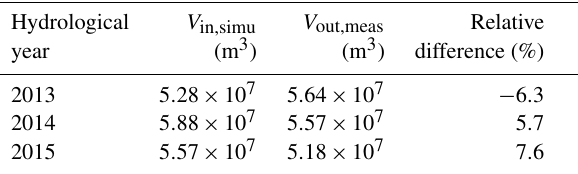
Table 3. Comparison of the total volume of water ( V in,simu ) simu- lated by Alpine3D to percolate at the bottom of the watershed soil columns over each year, and the measured total volume of water ( V out,meas ) flowing out of the catchment each year via the